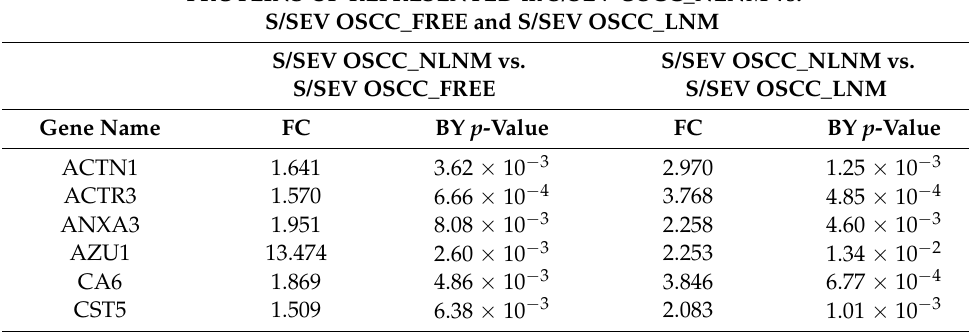
Table 7. Proteins specifically up-represented in S/SEV OSCC_LNM. PROTEINS UP-REPRESENTED in S/SEV OSCC_NLNM